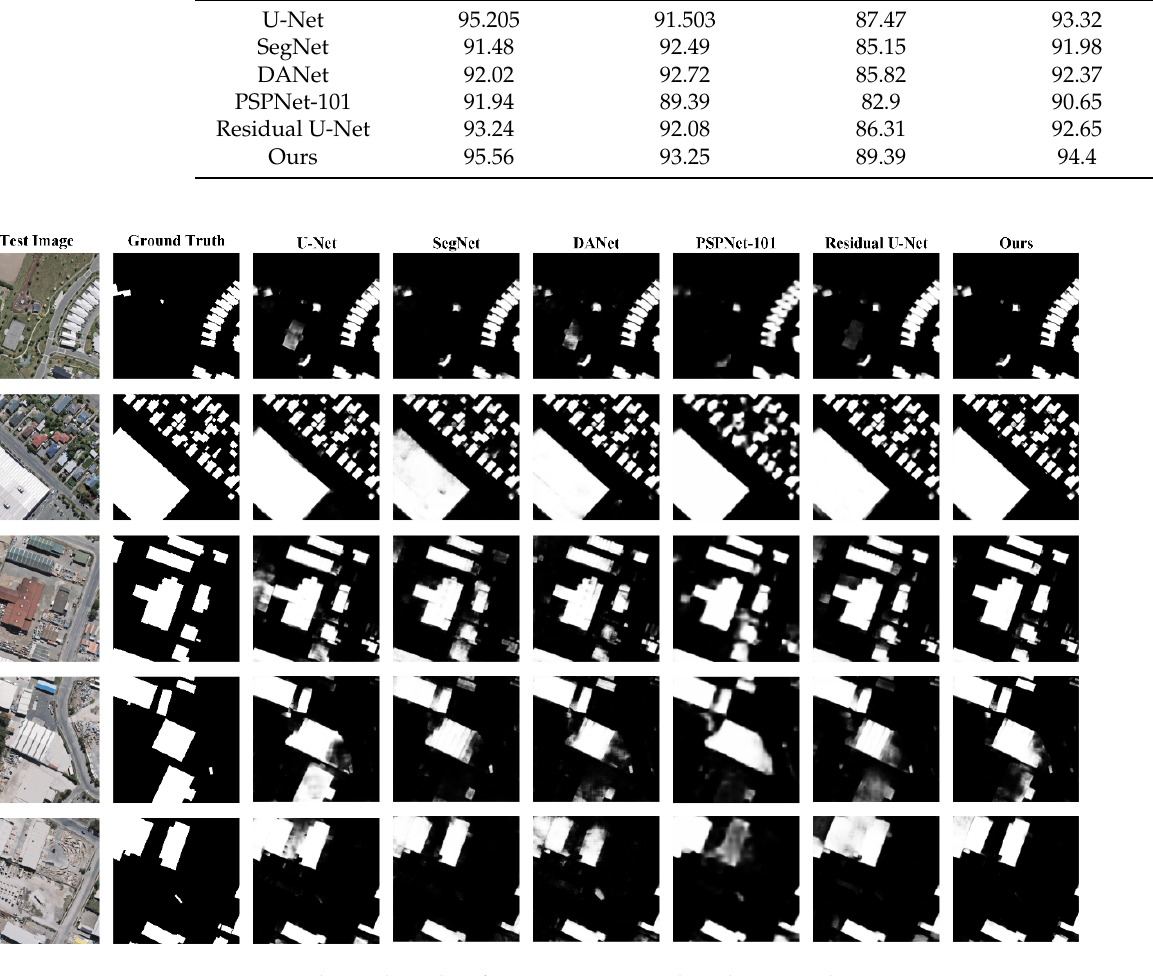
Figure 14. Several visual results of comparisons tested on the WHU dataset.